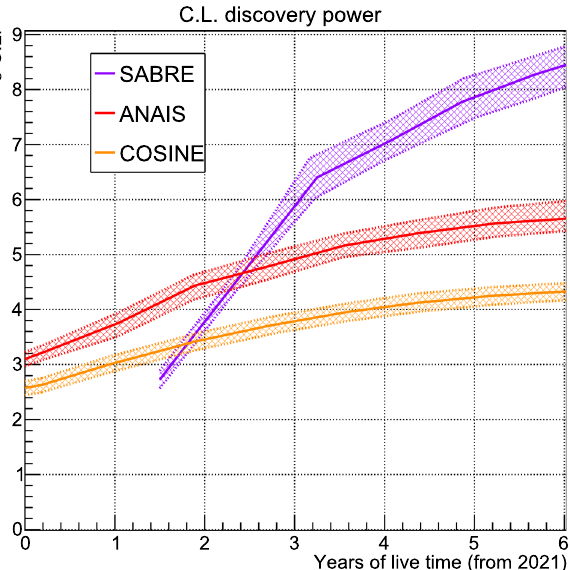
Fig. 8 Conservative discovery power of NaI detectors, as a function of live time. Cross hatched regions indicated 1 σ statistical uncertainty bands